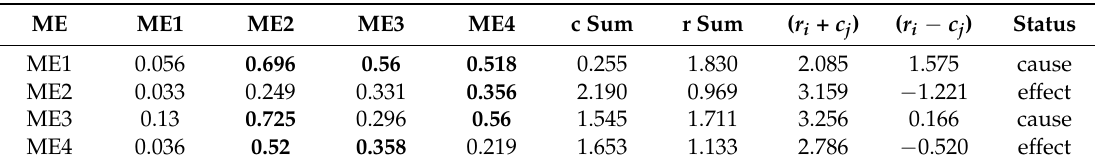
Table 9. The total relation matrix for mechanical FMs.